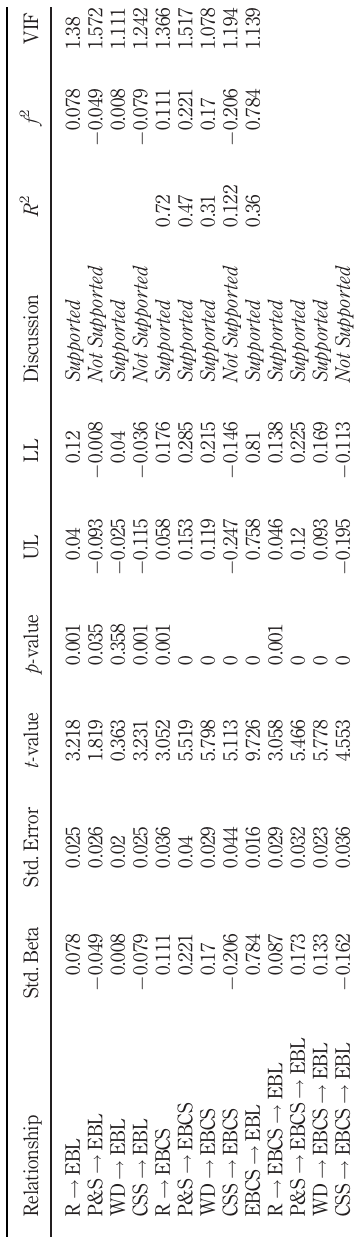
Table 5. Hypotheses